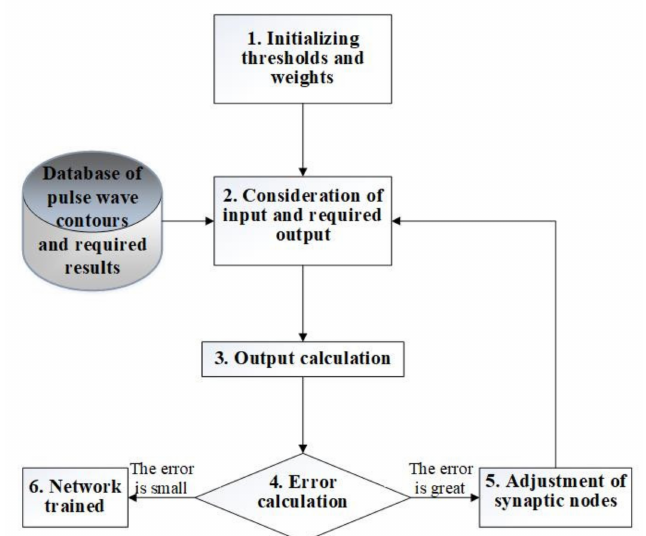
Figure 10. A variant of the neural network learning